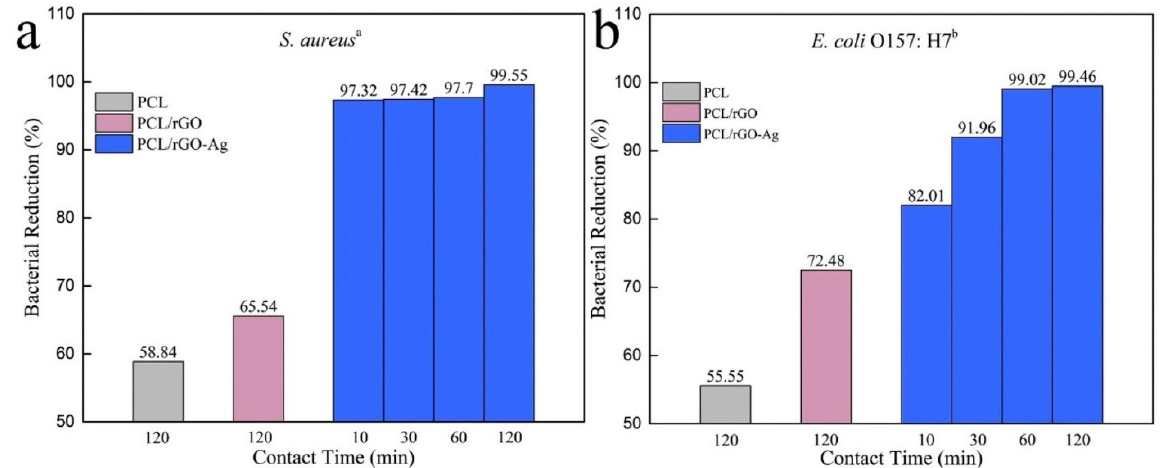
Figure 17. Antibacterial characteristics of PCL/rGO-Ag composites. ( a ) S. aureus inoculum was 7.00 × 10 5 CFU/sample. ( b ) E. coli O157:H7 inoculum was 6.33 × 10 5 CFU/sample [56]. Reproduced with permission from ref [56]. Copyright 2020 Elsevier.